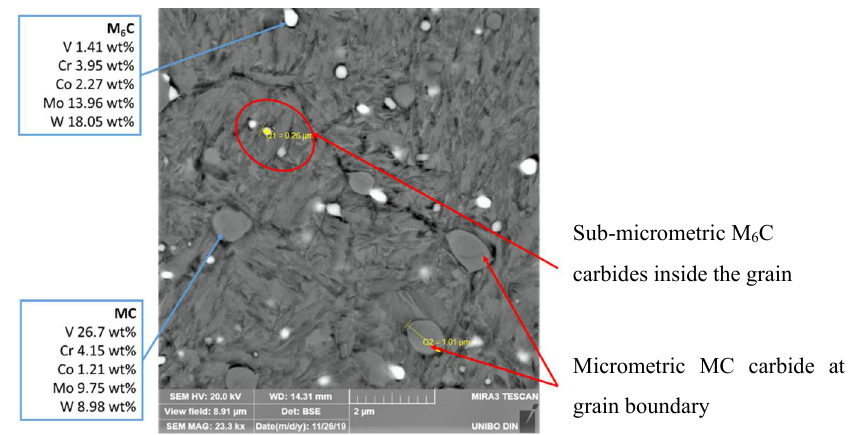
Figure 5. Representative SEM-BSE micrograph of the K890-II treated steel with MC carbides along grain boundaries and M6C carbides inside grains. The light grey carbides, M6C type, are Mo and W rich, while the dark grey carbides MC type are V rich.